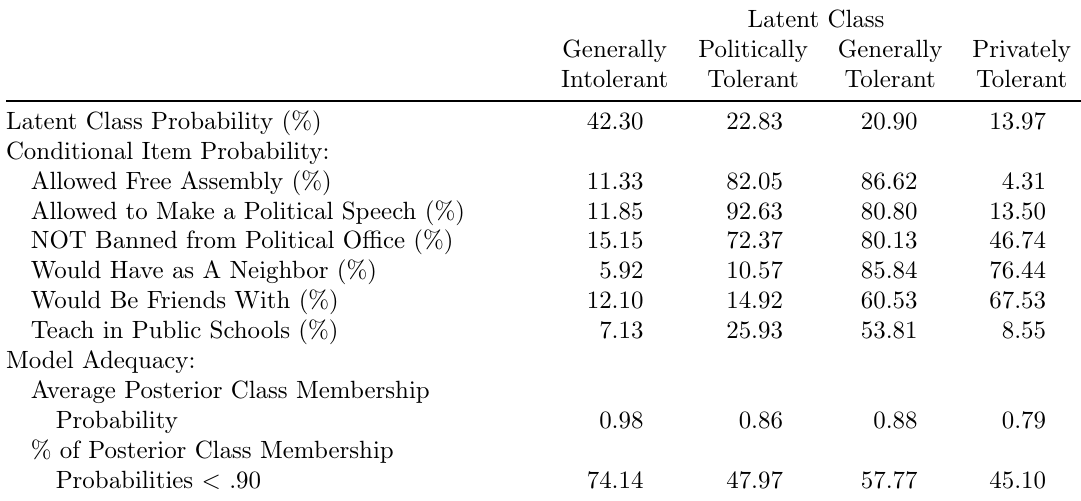
Table 5: Latent Class Analysis of Profiles of Tolerance